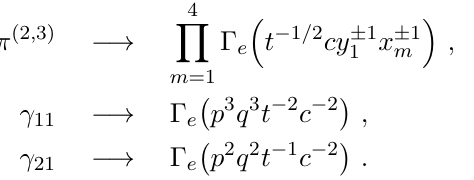
[USp(8)]. Two (cid:13)ipping (cid:12)elds (cid:13) 11 and (cid:13) 21 , [2 ; 1 2 ] h i h i D (1) D (1) and Tr 2 D (2) D (2) [1 2] [1 2]